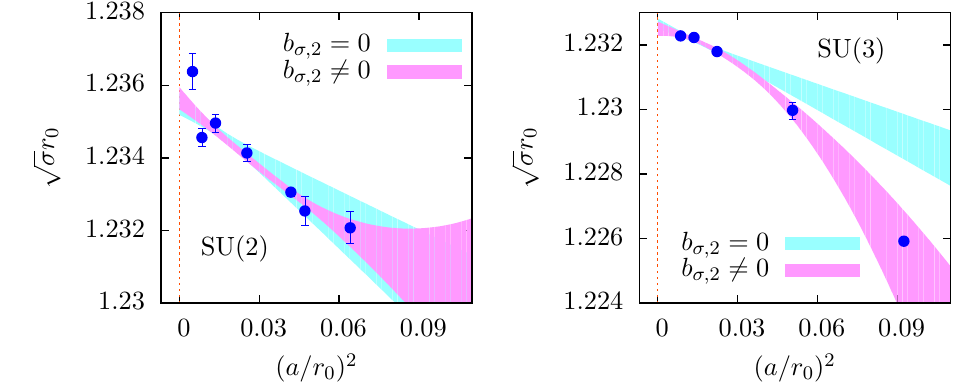
Figure 2 . Continuum extrapolations of p (cid:27) ( ii ) r 0 for SU(2) (left) and SU(3) gauge theory (right).